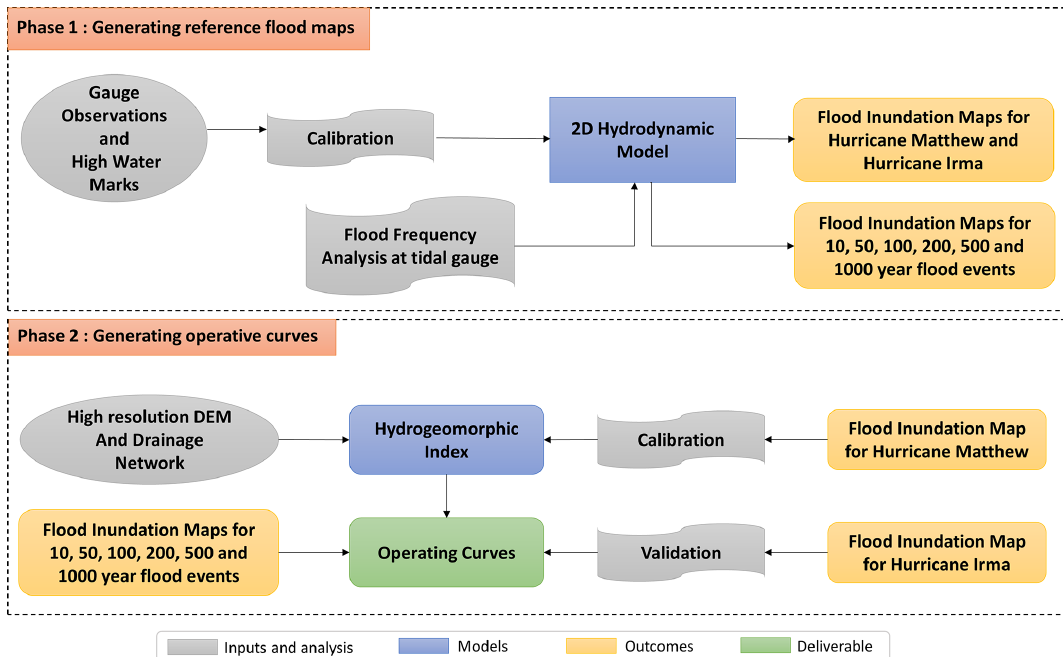
Figure 2. Flowchart of the proposed approach for generating hydrogeomorphic threshold operative curves. In Phase 1, the 2D hydrodynamic model is calibrated and generates the required reference maps for the next phase. In Phase 2, the reference maps are used in conjunction with the hydrogeomorphic index to generate the operative curves for fast and real-time coastal flood hazard